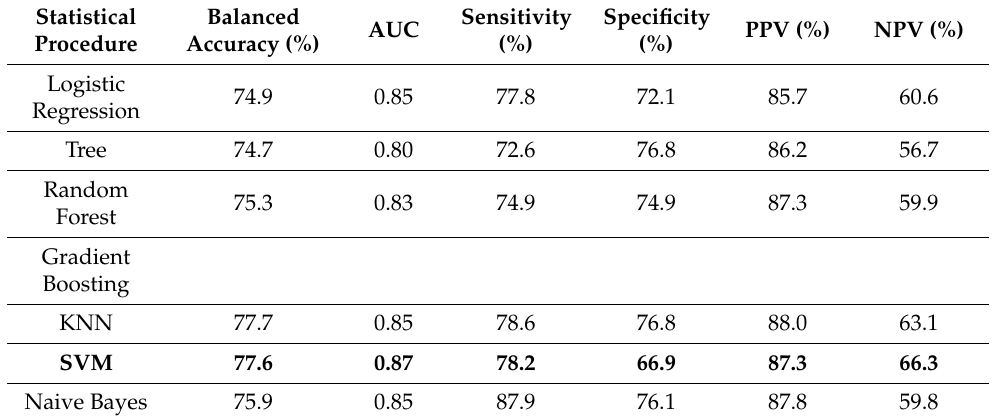
Table 2. Machine learning models and performance in nested cross-validation on training dataset 1 .